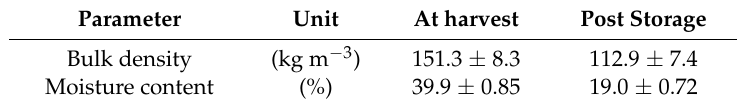
Table 8. Bulk density and moisture content of the chipped material before and after the storage.